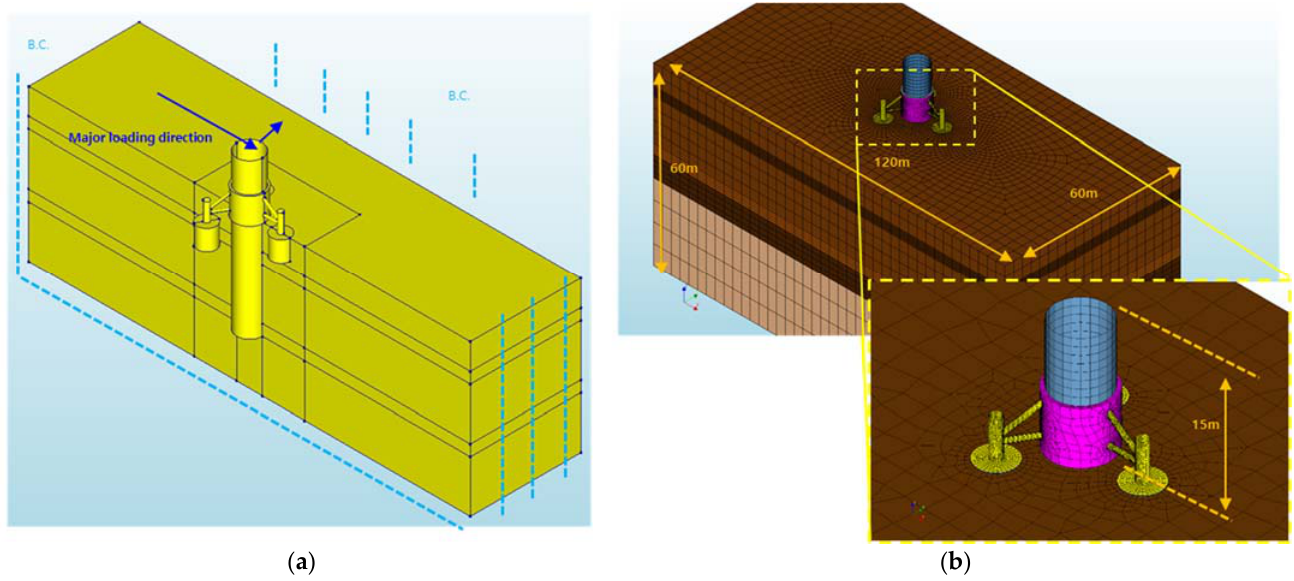
Figure 13. Model geometry and mesh (Case B): ( a ) load and boundary conditions ( b ) finite element mesh; where B.C.: boundary conditions. mesh; where B.C.: boundary conditions.